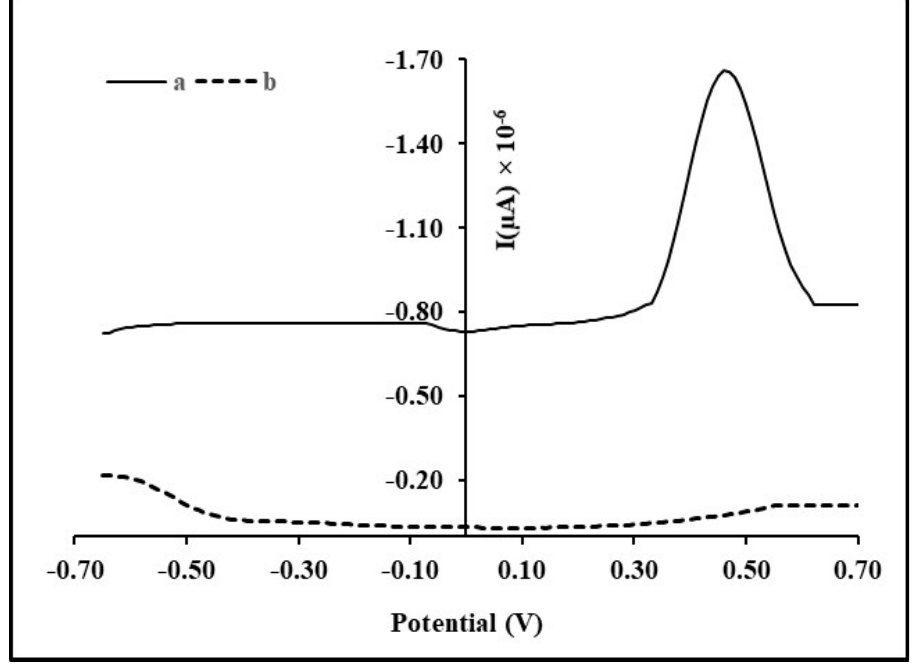
Figure 2. Stripping peak for Hg (II) at modified (a) and unmodified (b) carbon paste electrodes using differential pulse anodic stripping voltammetry. differential pulse anodic stripping